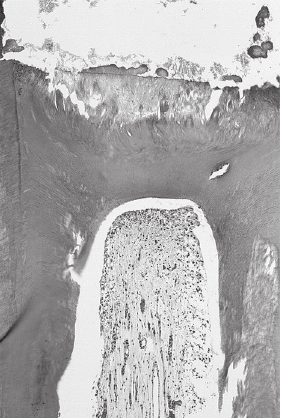
Figure 7. Group III (calcium hydroxide). Dentine bridge in direct contact with the pulp-capping material. Integral pulp tissue. HE; magnification X24.